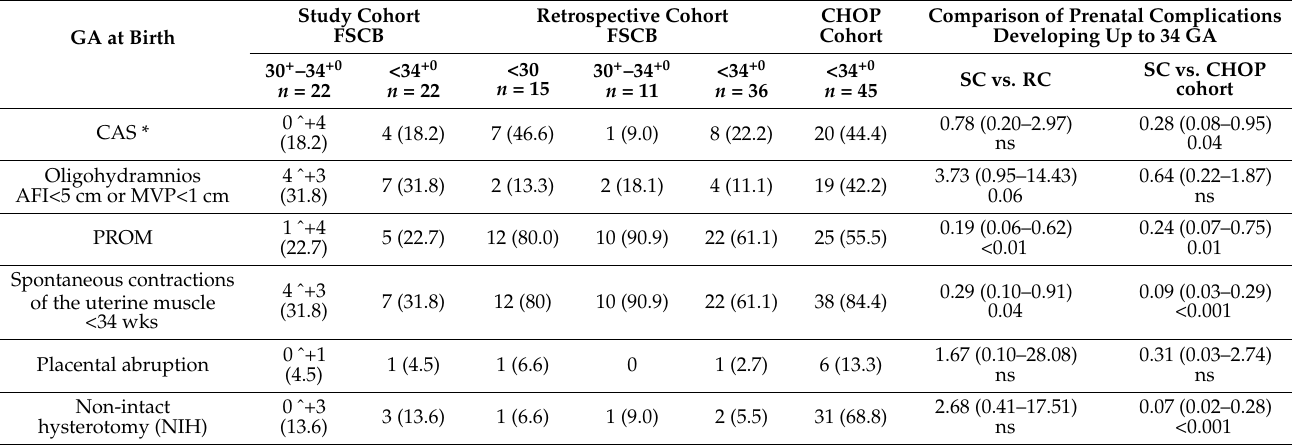
Table 4. Comparison of prenatal complications developing up to ≤ 34.0